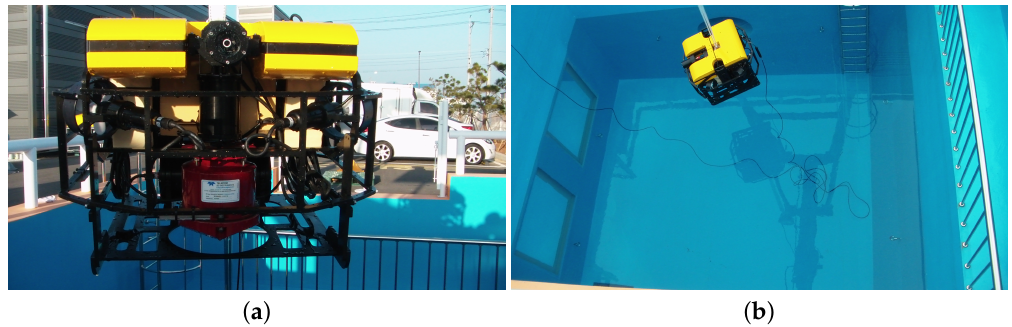
Figure 2. UUV and test tank used in experiment 1. ( a ) UUV front view; ( b ) launching UUV into test